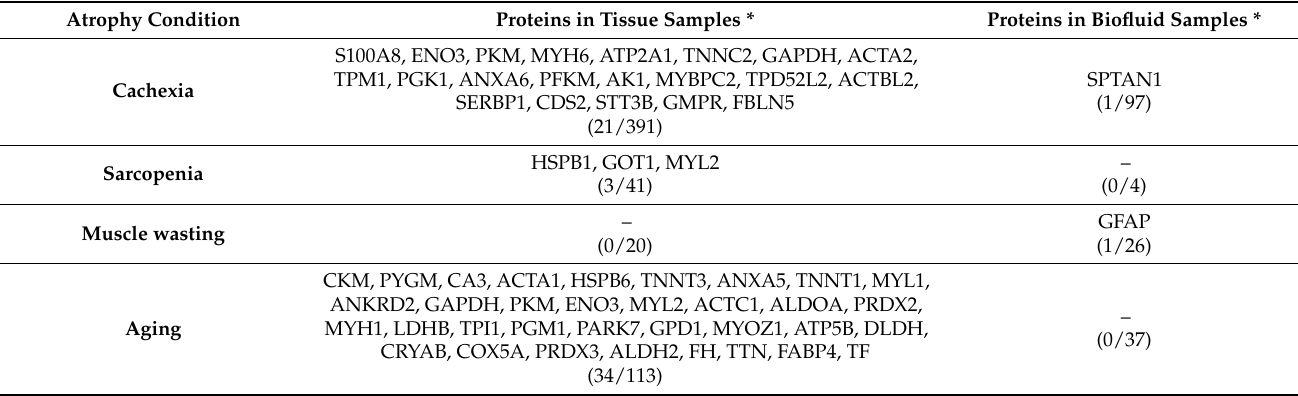
Table 3. List of overlapping proteins identified with each muscle-wasting